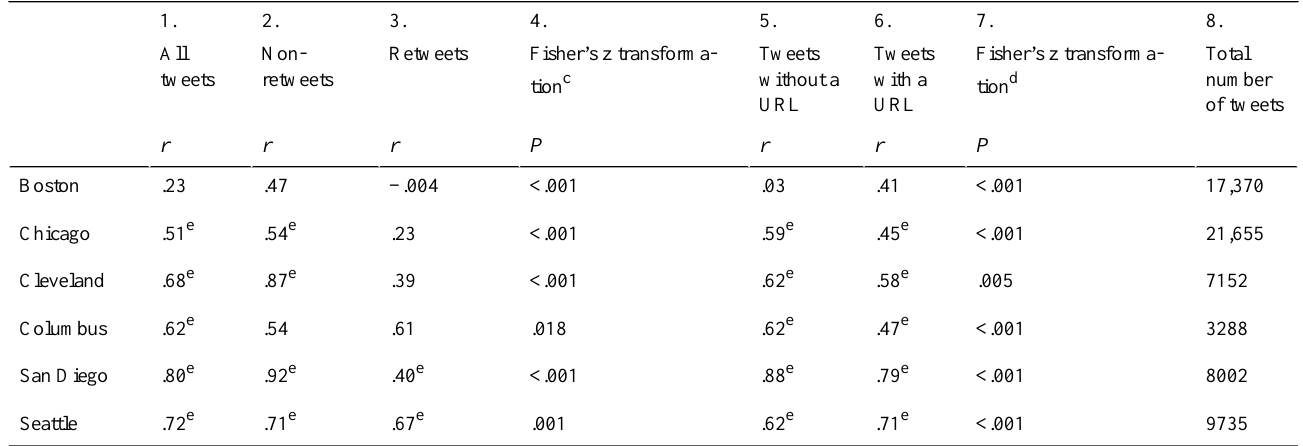
Table 4. Correlations between tweet rates and emergency department ILI a rates by city. b